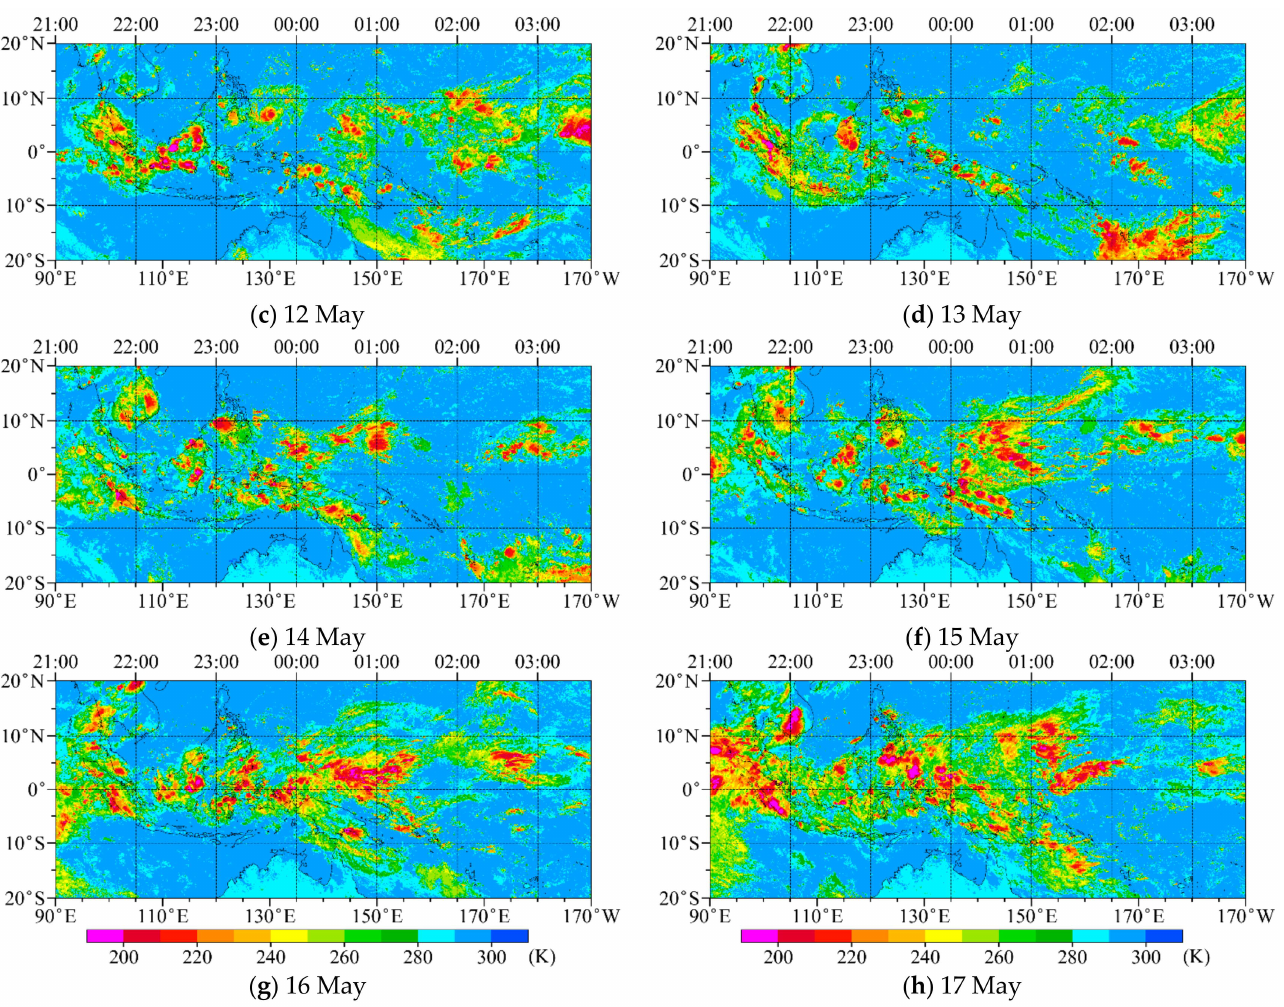
Figure 2. Brightness temperature observations at AHI channel 13 at 1500 UTC during 10–17 May 2021 within the analysis region of 90 ◦ E-170 ◦ W, 20 ◦ S-20 ◦